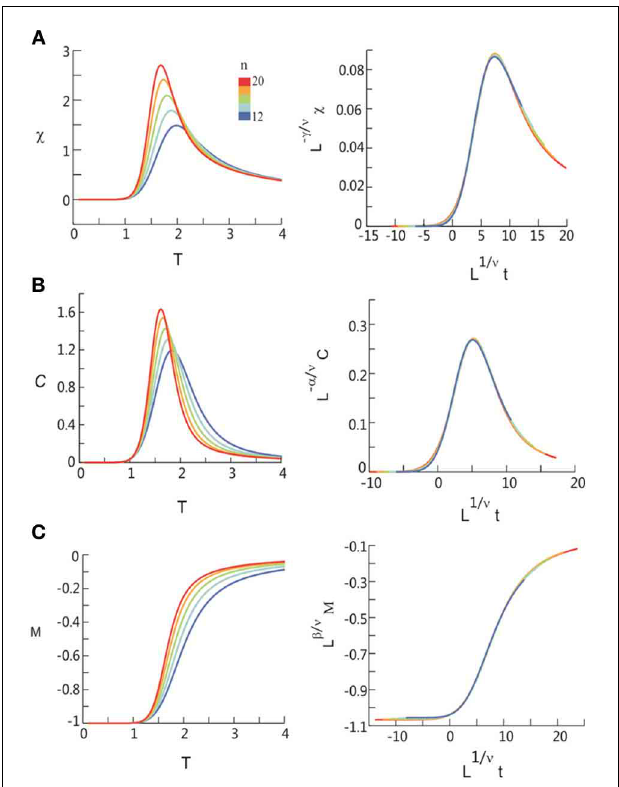
FIGURE 6 | Critical behavior in susceptibility, specific heat, and order parameter observed for neuronal avalanches in the human brain at macroscopic level, i.e., recorded with MEG. Susceptibility (A) , specific heat (B) , and order parameter (C) are plotted as a function of T for system size n = 12–20 (color code). Left: Original non-scaled functions. Right: Corresponding collapse using FSS analysis. Scaled quantities are plotted as functions of “reduced temperature,” t = the dimensionality of the system. Critical exponents: α , β , γ , and ν .